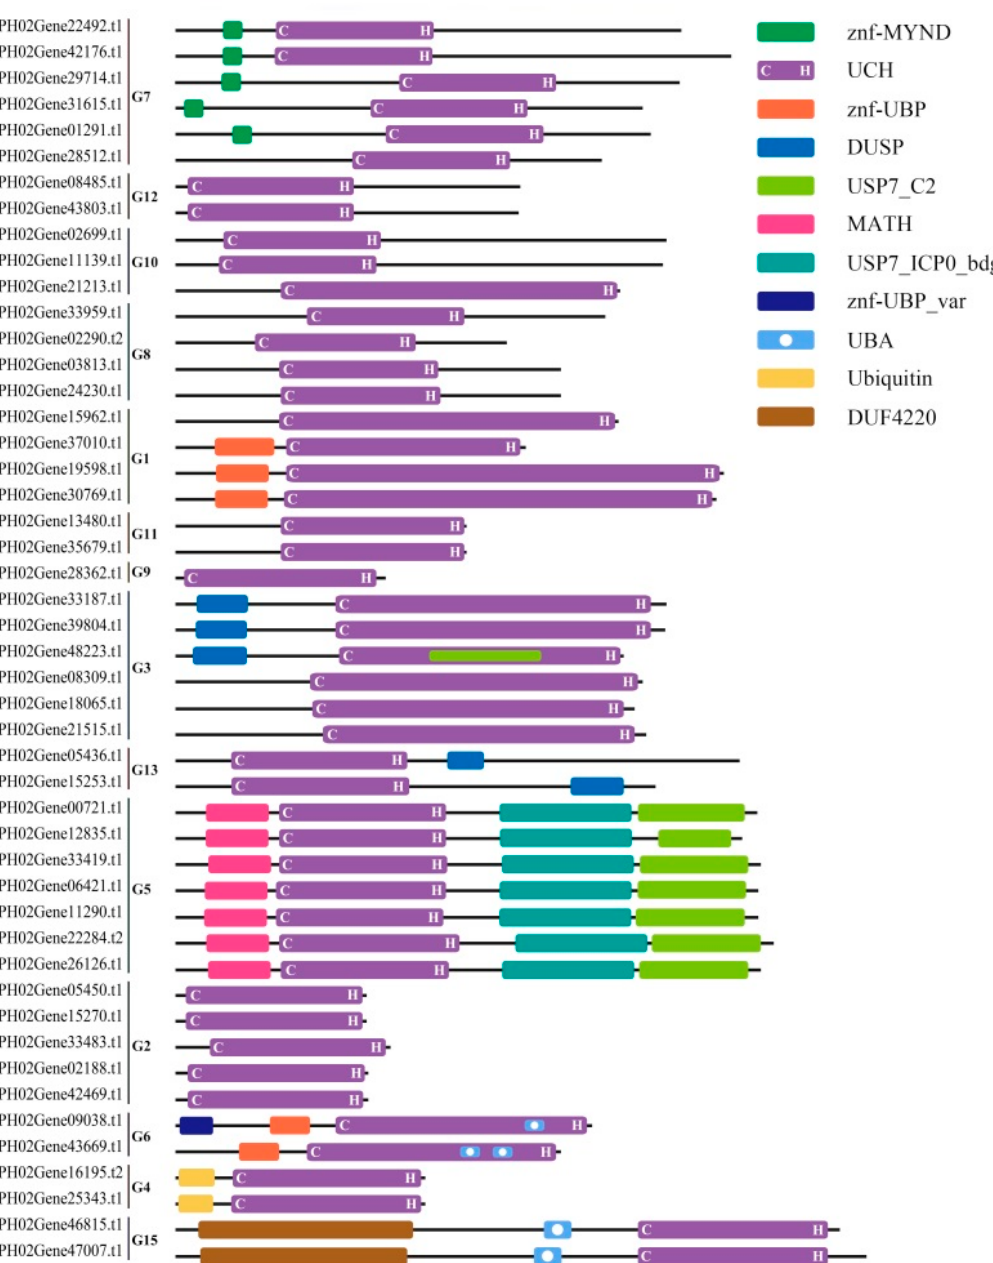
Table 1. Detailed information about 48 predicted PeUBP proteins in moso bamboo. The last column lists the number of exons in each gene. CDS, the coding sequence of a gene; MW, molecular weight; pI, protein isoelectric point.